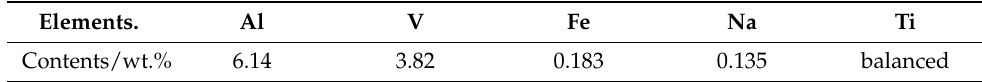
Table 1. Powder elemental composition (weight